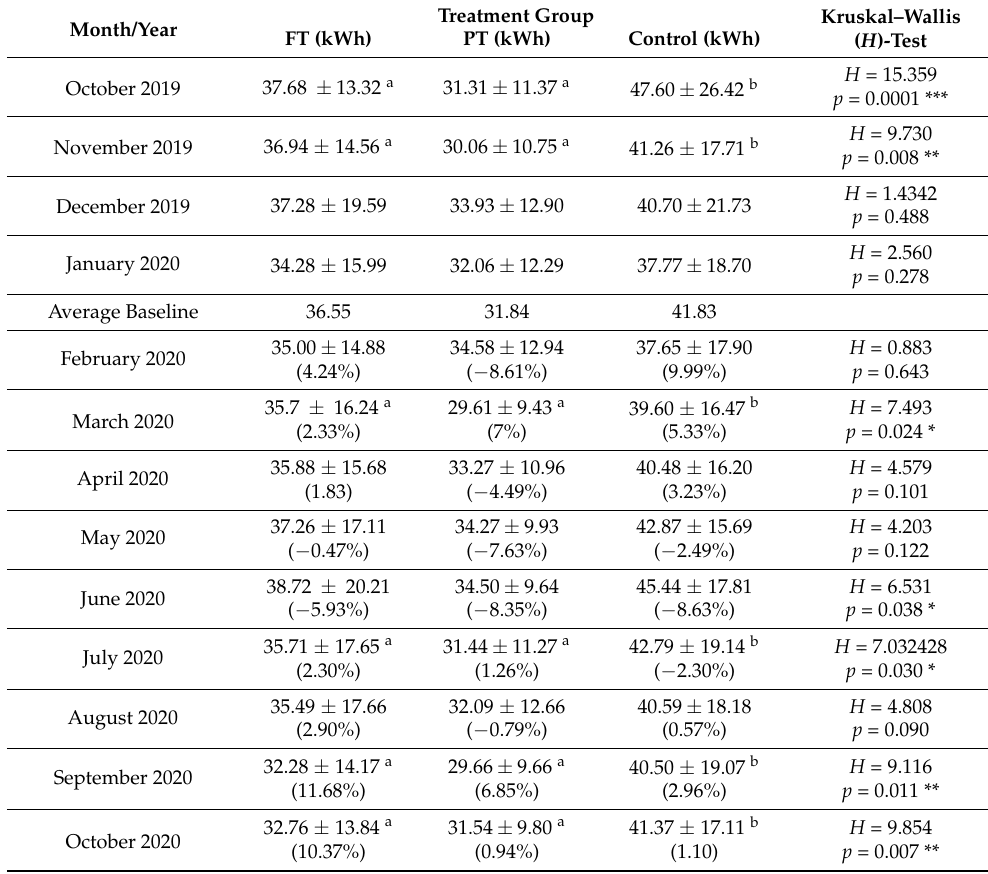
Table 2. Mean ( ± SD) monthly household electricity consumption (in kWh) changes before and after interventions. Reductions (electricity saving) and increases in consumption are represented by positive and negative values (%) in brackets. Letters a, b represent significant differences between treatment